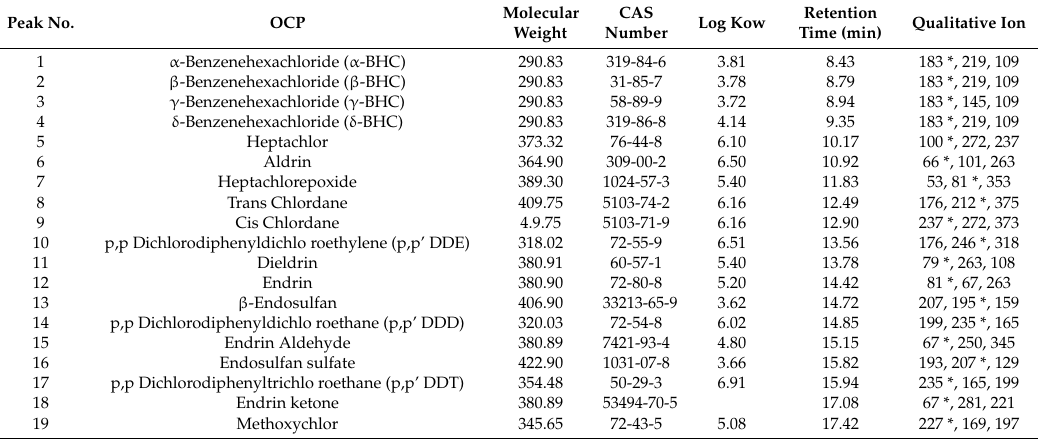
Table 5. The performance characteristics of the proposed FPSE/GC-MS analytical method. Peak No. OCP